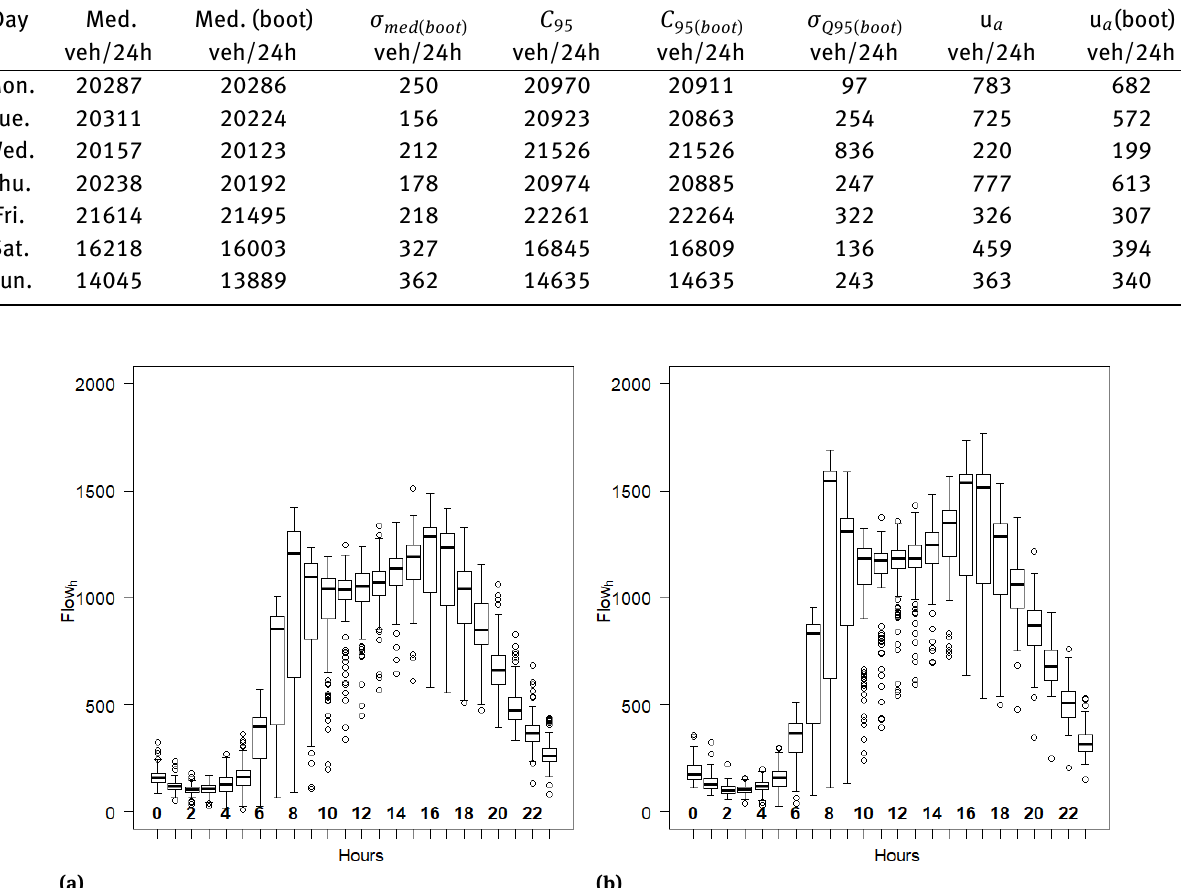
Figure 4: Annual hourly traflc flow box plots for all vehicle sets for sub-interval 24h a) in 2012, b) in